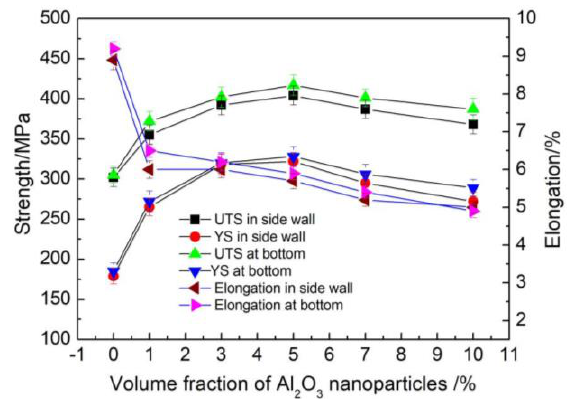
Figure 17. Mechanical properties of rheoformed 2024 aluminum matrix composite component